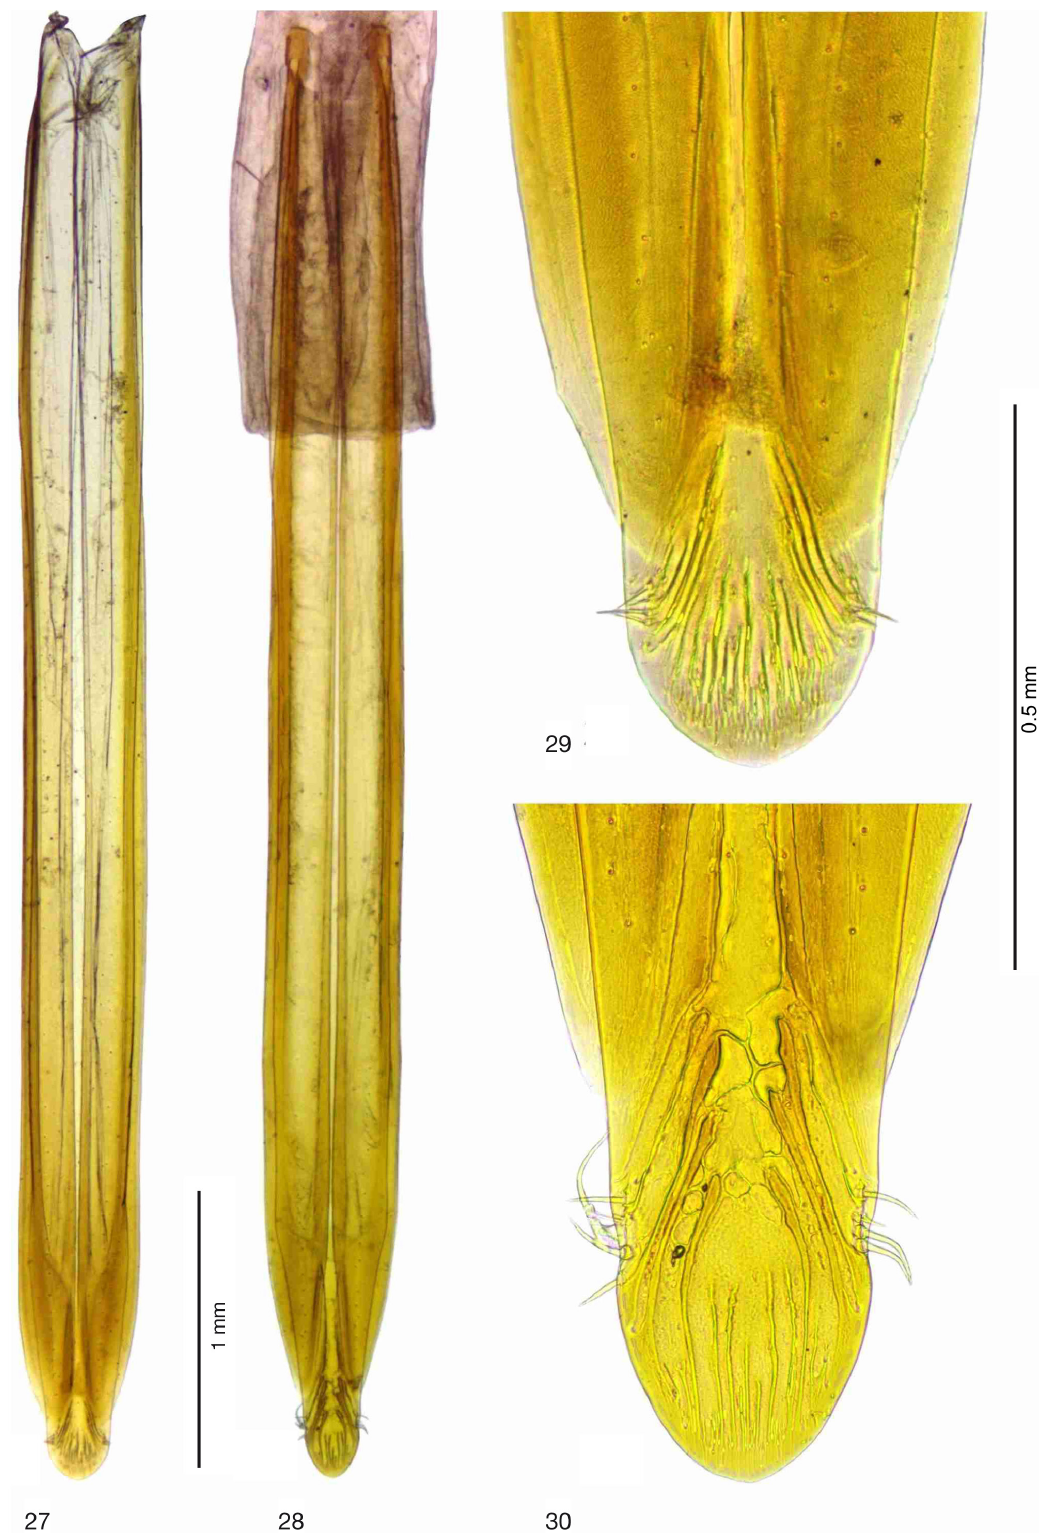
Figs 27–30. Ichneumonopsis spp., aculeus. 27 . I. burmensis Hardy, 1973, entire aculeus. 28 . I. taiwanensis sp. nov., entire aculeus. 29 . I. burmensis Hardy, 1973, aculeus apex. 30 . I. taiwanensis sp. nov., aculeus